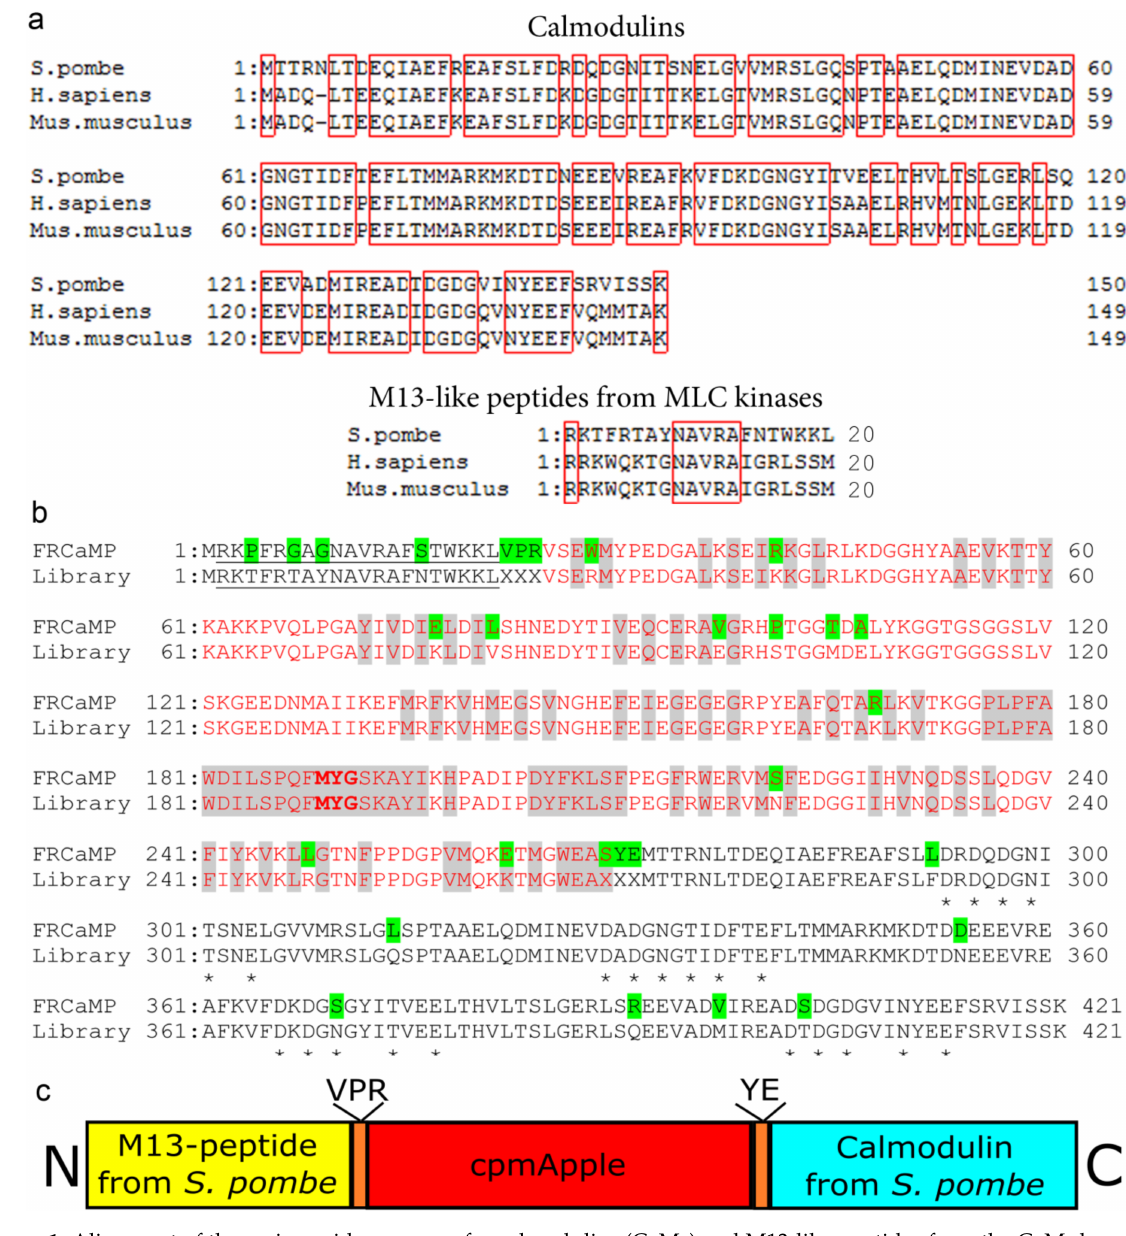
Figure 1. Alignment of the amino acid sequences for calmodulins (CaMs) and M13-like peptides from the CaM-dependent myosin light chain (MLC) kinases found in different species ( a ) and for the FRCaMP indicator and its original library ( b ) and FRCaMP design ( c ). ( a ) Identical residues are highlighted with red boxes. ( b ) Alignment numbering follows that used for the FRCaMP protein. Mutations in FRCaMP relative to the original library, as well as linkers between the fluorescent (in red) and calcium-binding parts, are highlighted in a green color. The residues buried inside the β -barrel of the fluorescent part are highlighted in a grey color. Residues in the CaM-part that are assumed to bind Ca 2+ ions are highlighted with stars at the bottom. The M13-peptide is underlined. The chromophore-forming residues MYG are highlighted in bold. ( c ) The arrow deciphers the amino acid composition of the